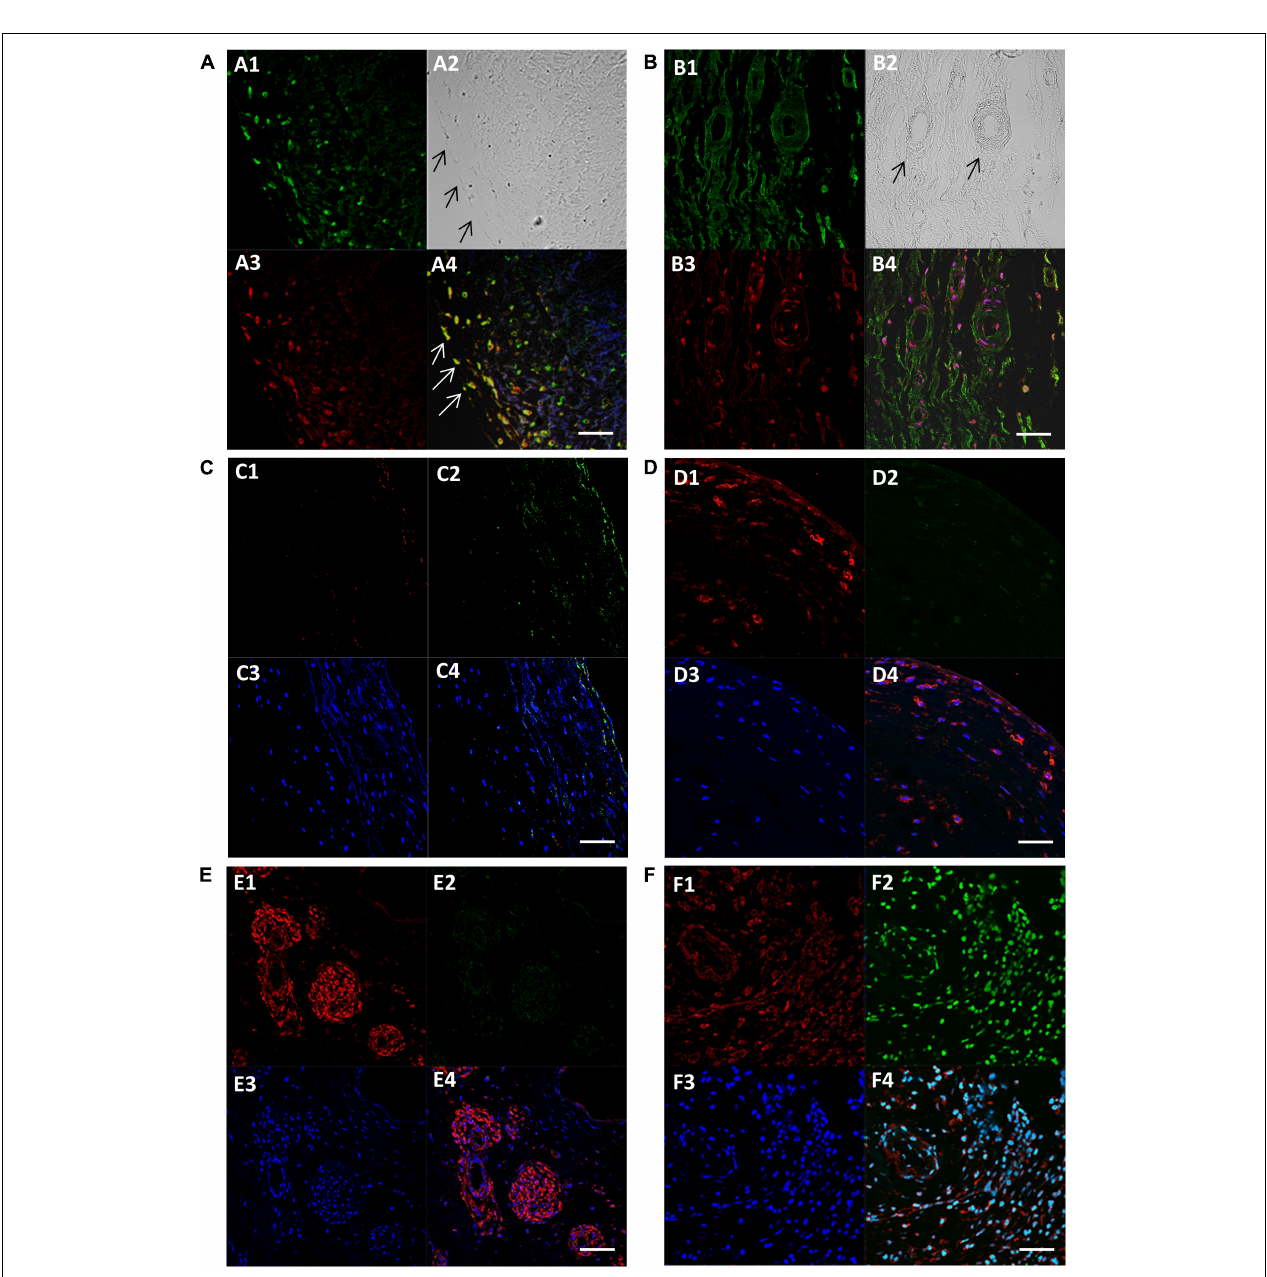
FIGURE 3 | Fluorescent images showing expression of SM-myosin (A1) , phase contrast image of the same location showing the edge of the cusp on the left (A2) , expression of Runx2 (A3) , and co-localisation of SM-myosin and Runx2 (A4) in a BAV cusp. Expression of SM-myosin (B1) , phase contrast (B2) , Runx2 (B3) , and co-localisation of SM-myosin and Runx2 (B4) in a RHV cusp. Expression of myocardin (C1–F1) , PCNA (C2–F2) , DAPI (C3–F3) and co-localisation of all three respective previous panels (F1–F4) in a normal control ( C panel), BAV cusp ( D panel), RHV cusp ( E panel), and tumour tissue ( F panel) as positive control for PCNA. Scale bar represents 50 µ